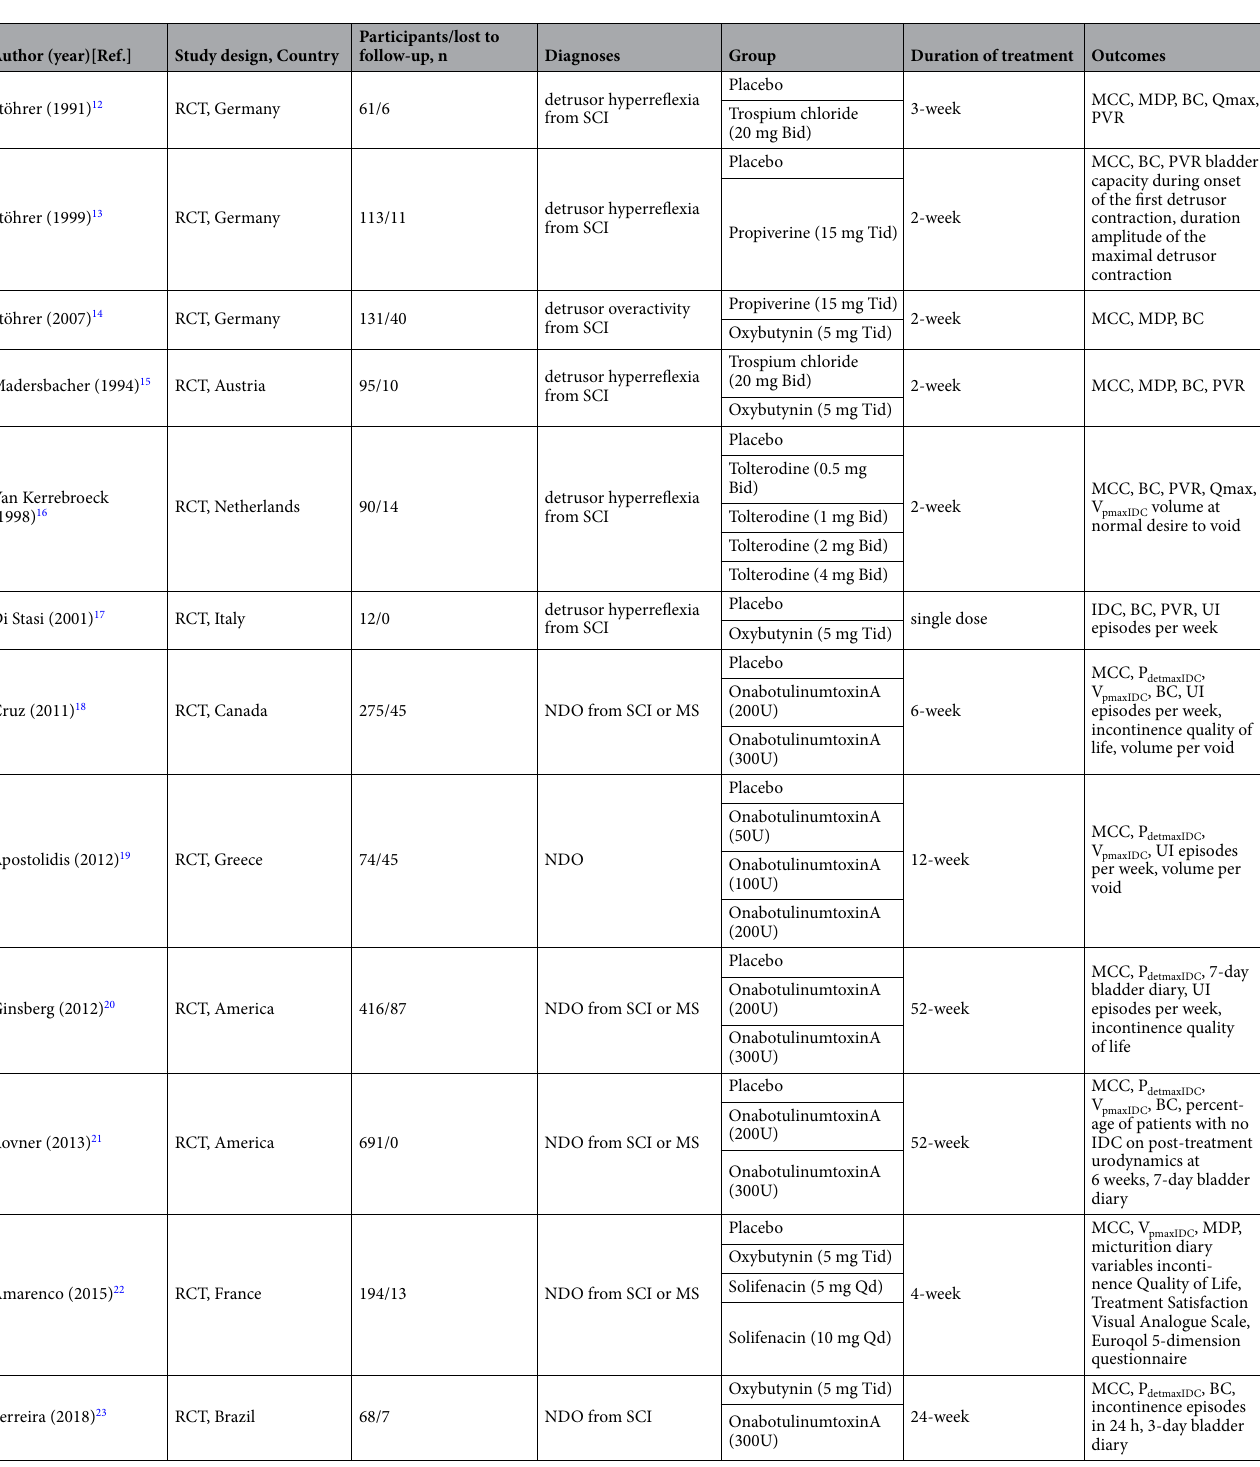
Table 1. Baseline characteristics of included studies. Bid twice a day, Tid three times a day, RCT randomized controlled trial, SCI spinal cord injury, MS multiple sclerosis, NDO neurogenic detrusor overactivity,